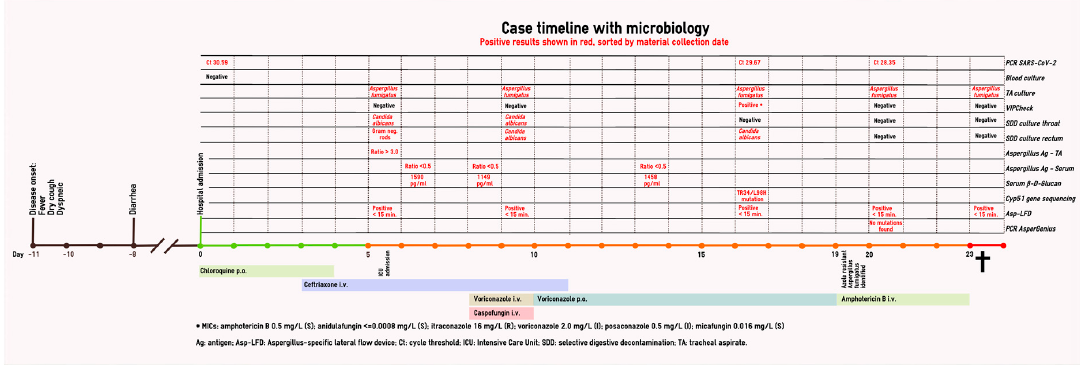
Figure 2. Case timeline with microbiology.